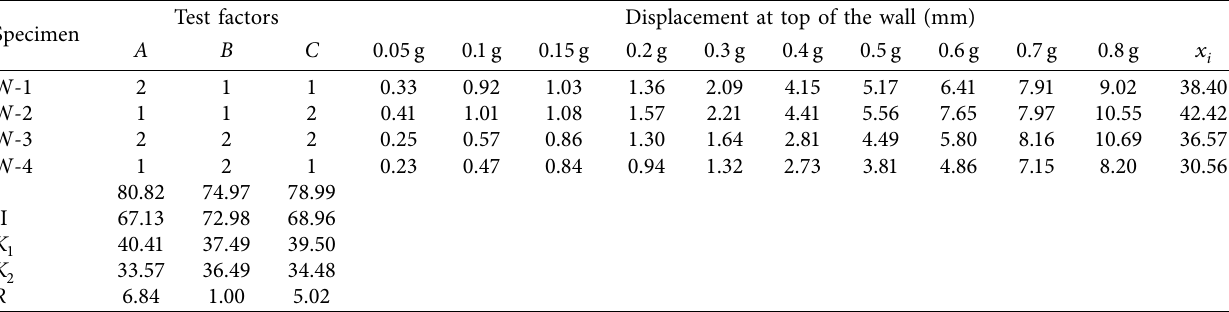
Table 7: Analysis of result of displacement at the top of the wall. Specimen